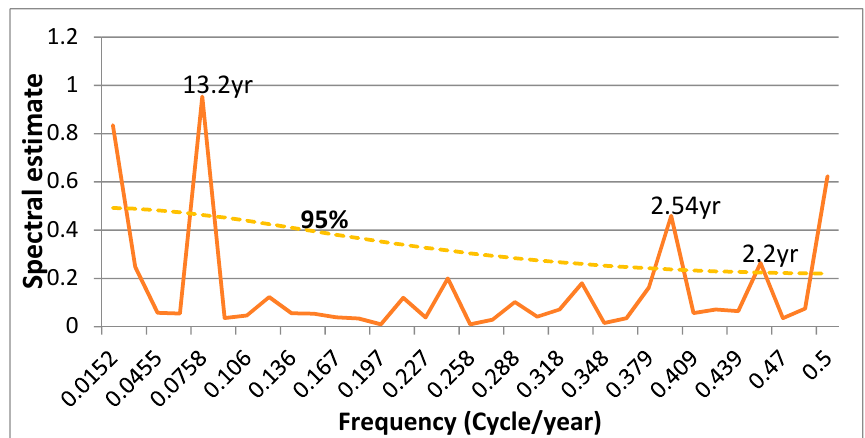
Figure 3. Spectral analysis of lower stratospheric temperature at 50 hPa (LST) at the Arabian Peninsula